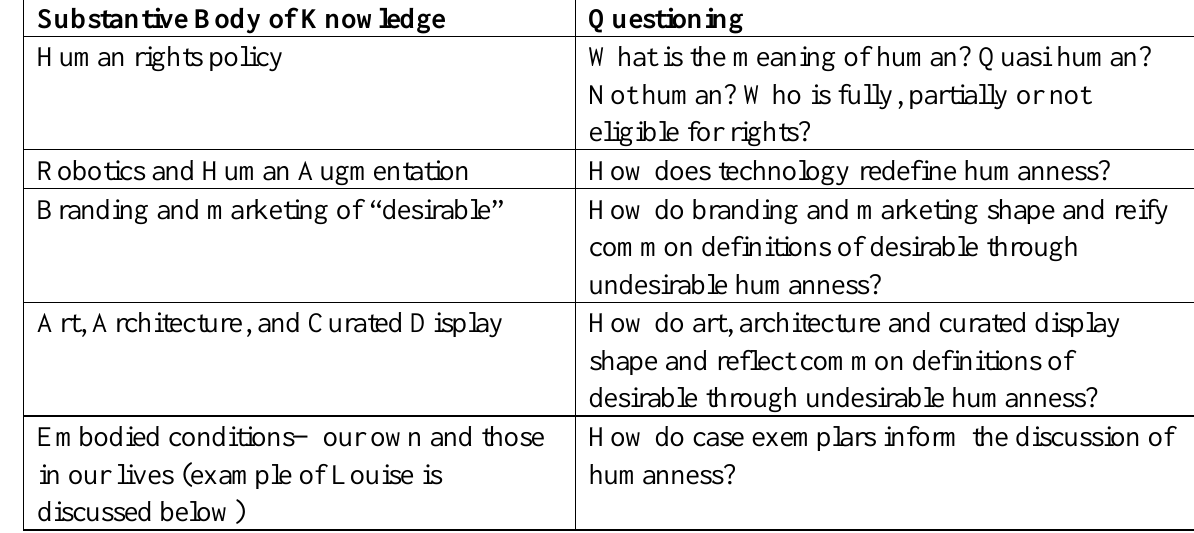
Table 1. Arena and Our